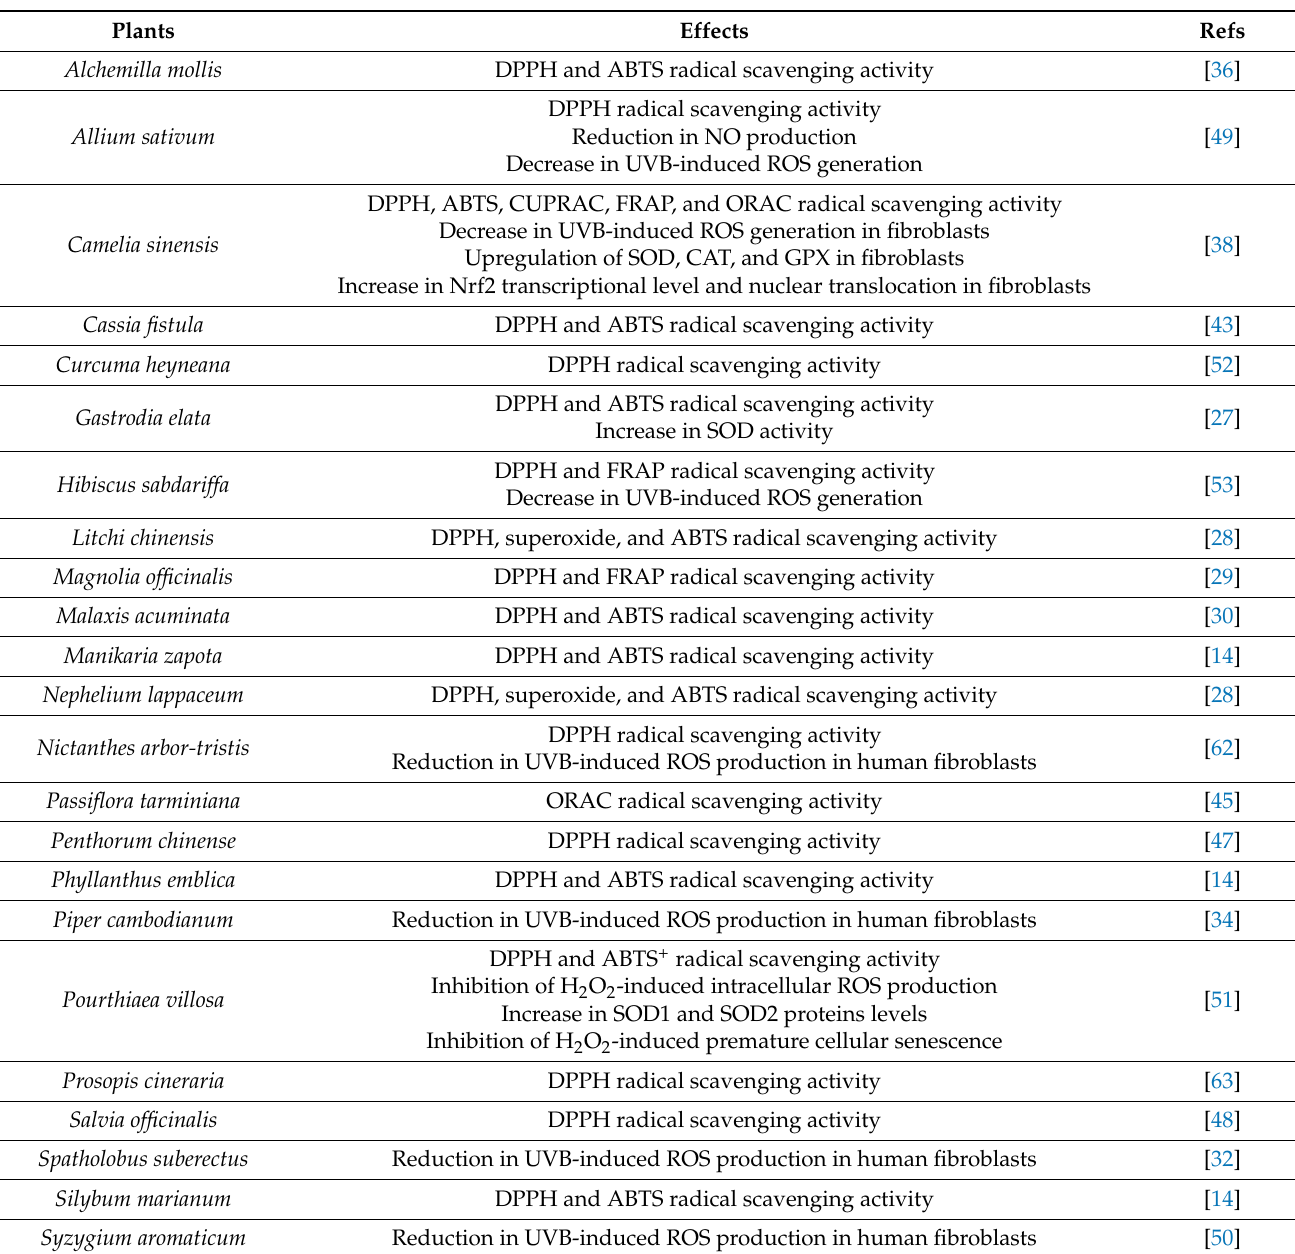
Table 2. Main plant herbal products with anti-aging effects by acting on oxidative